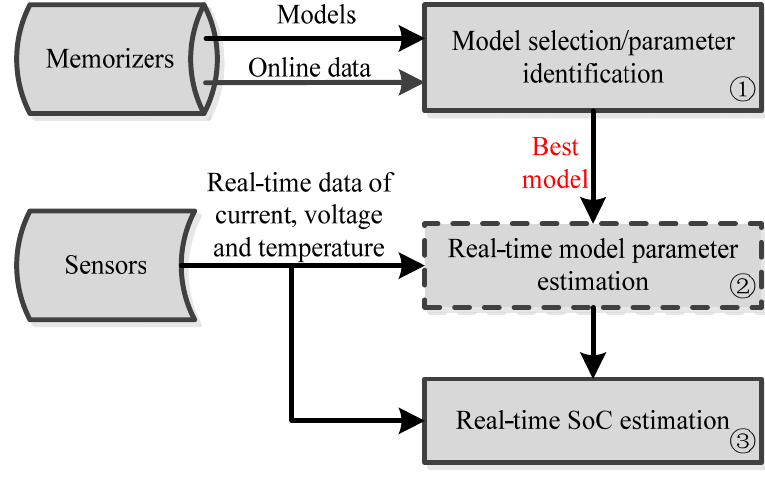
Figure 1. Model-based state of charge (SoC) estimation flow